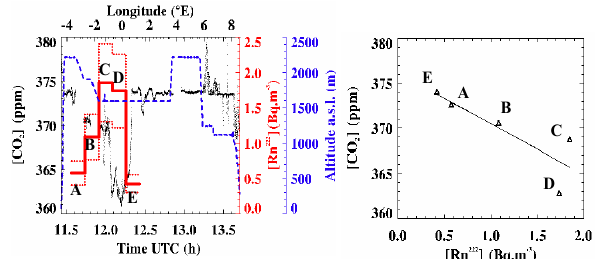
Fig. 7. Left panel: Radon concentration (red plain line) with mea- surement precision (red dashed line), CO 2 concentration (black plain line) and altitude (blue dashed line) concentrations vs. time measured during CAATER 1 on 25 May 2001. The longitude is in- dicated on top. Jumps in Radon and CO 2 concentrations are defined as events A to E. Right panel: CO 2 vs. Radon 222 concentration for events A to